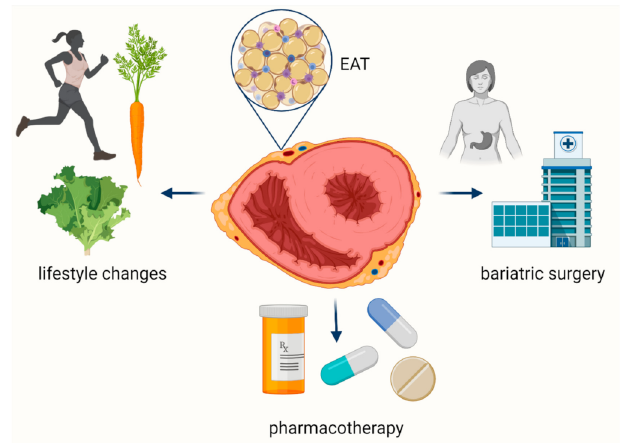
Figure 3. Therapeutic options to affect epicardial adipose